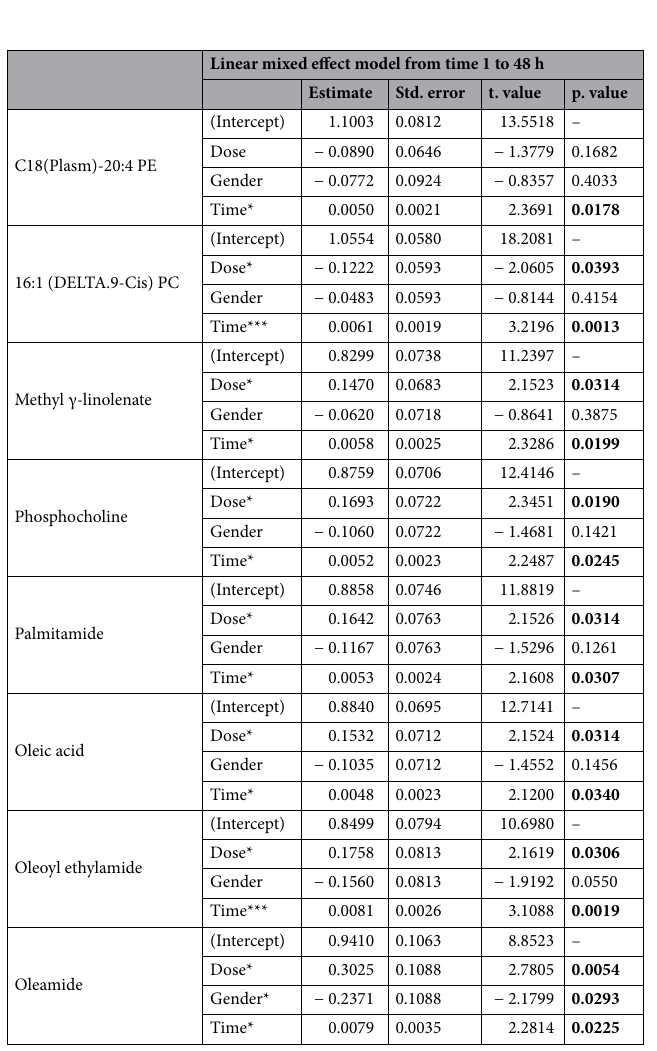
Table 2. Linear mixed effects model showing the abundance of annotated metabolites as the response variable while gender, dose, and time remain the independent variables. A comprehensive list of all detected features with test statistics (p-value, FDR-adjusted p-value, fold change and log(2) fold change) for each tested group post drug administration compared to pre-drug administration for both tested doses. Significant values are given in bold. *Indicates p < 0.05, ** < 0.01, *** < 0.001.